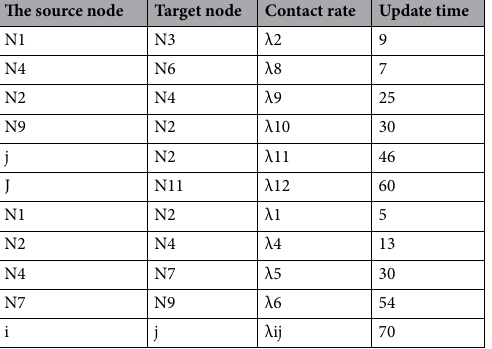
The source node